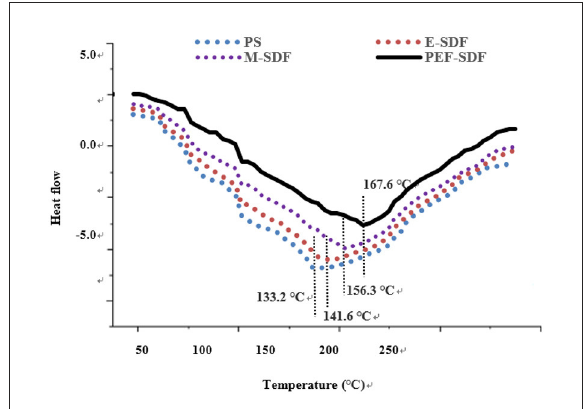
FIGURE4 The scanning electron microcopy (SEM) images of PS (a) , E-SDF (b) , M-SDF (c) , and PEF-SDF (d) .